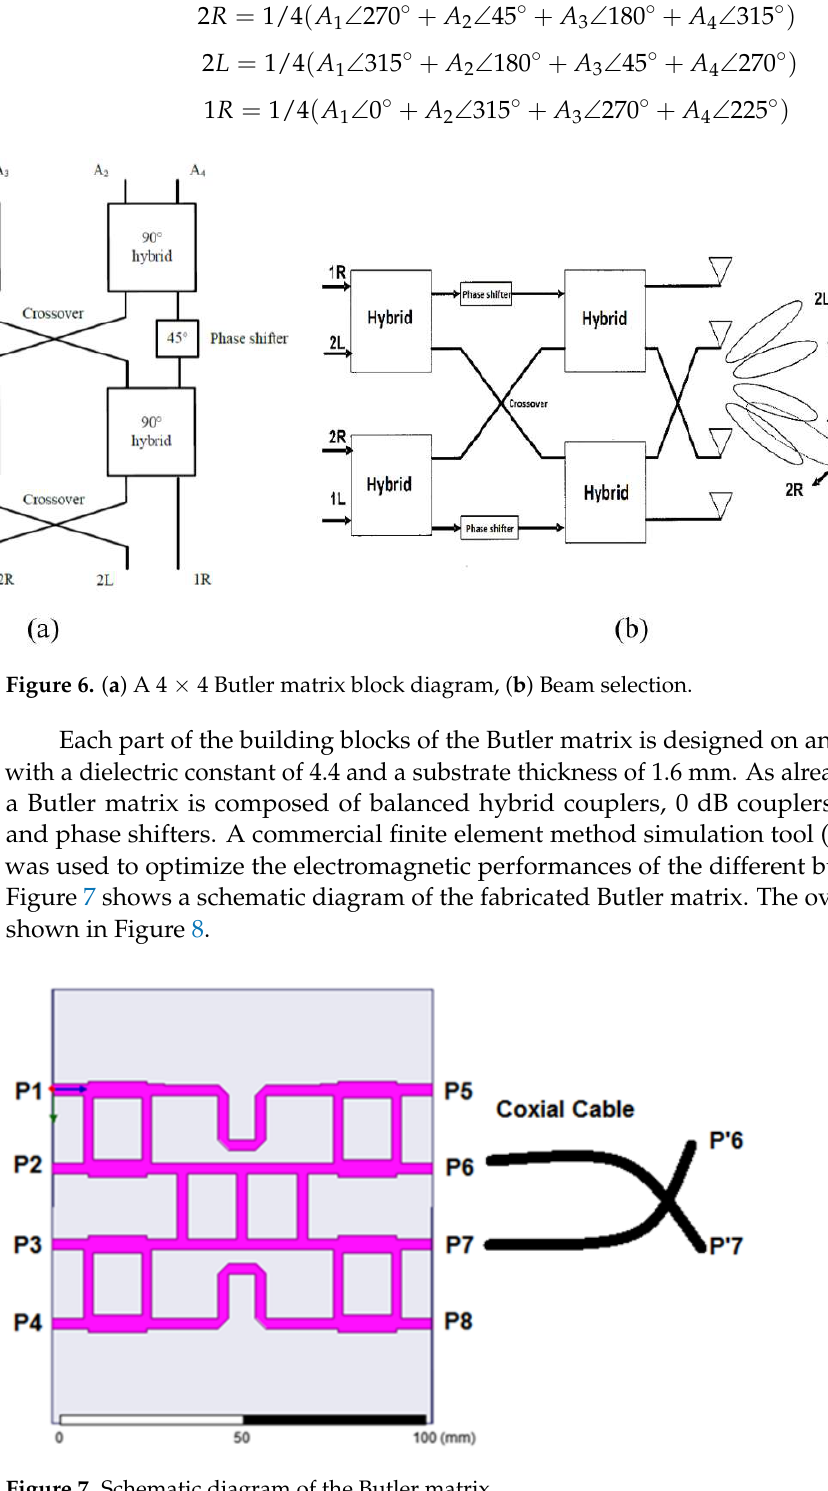
Figure 7. Schematic diagram of the Butler